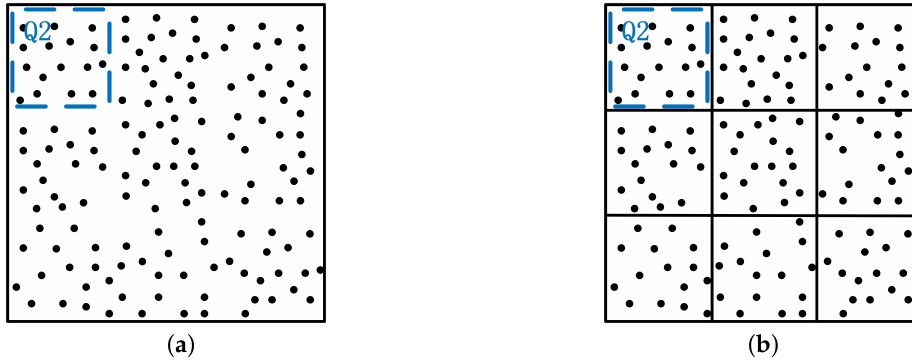
Figure 4. The relationship of uniform data distribution and partition structure. ( a ) example of uniform distribution; ( b ) corresponding partition and range